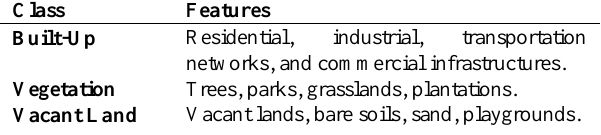
Table 2. LULC Classes Considered in the study.